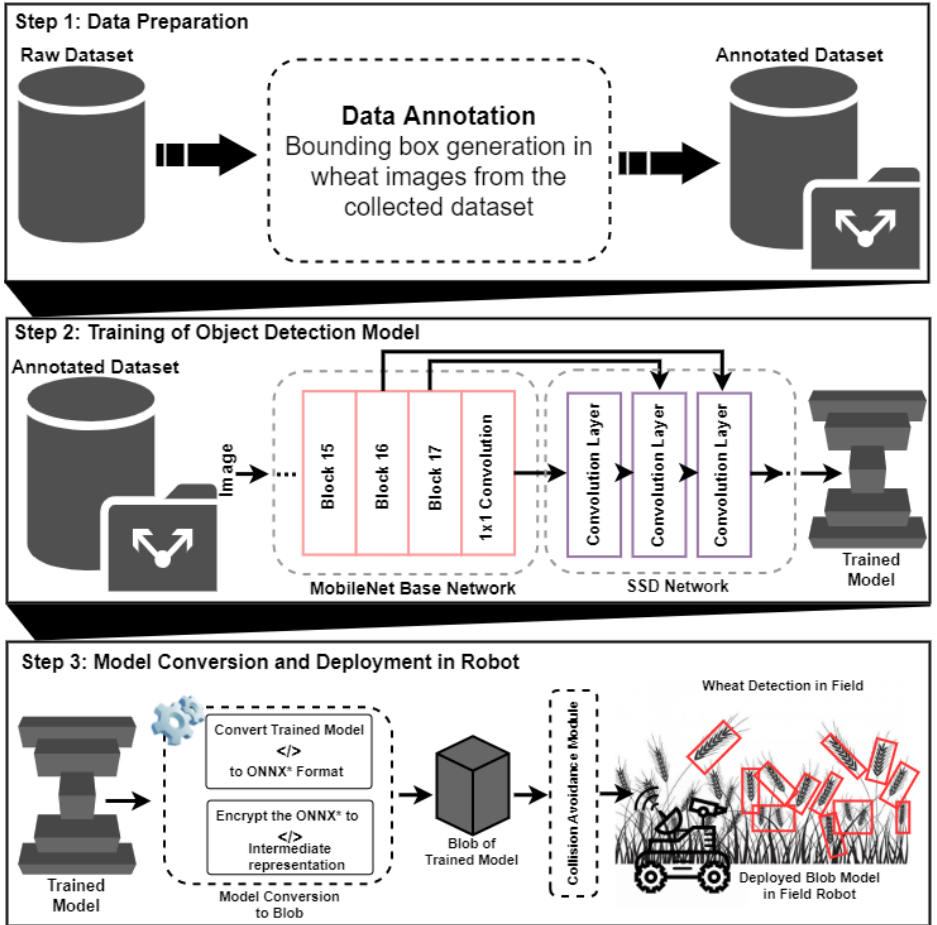
Figure 1. The visual overview of our proposed spatial AI system for collision avoidance in wheat